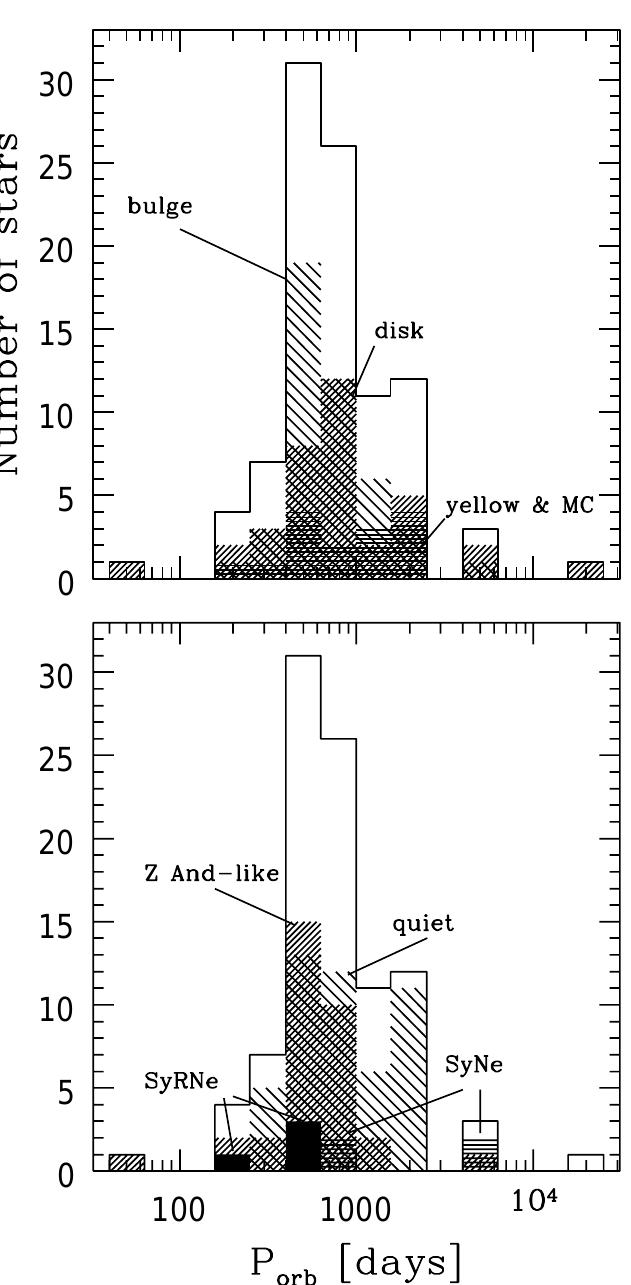
Fig. 1. The orbital period distribution. The shaded regions denote different pop- ulations (upper panel) – the MCs and yellow, disk and bulge, as well as different activity classes (lower panel) – recurrent and ordinary symbiotic novae, systems with Z And-like activity, and systems without recorded